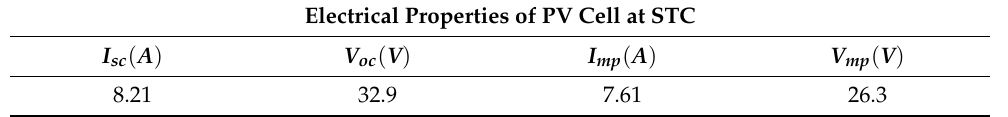
Table 2. Electrical parameters of the PV